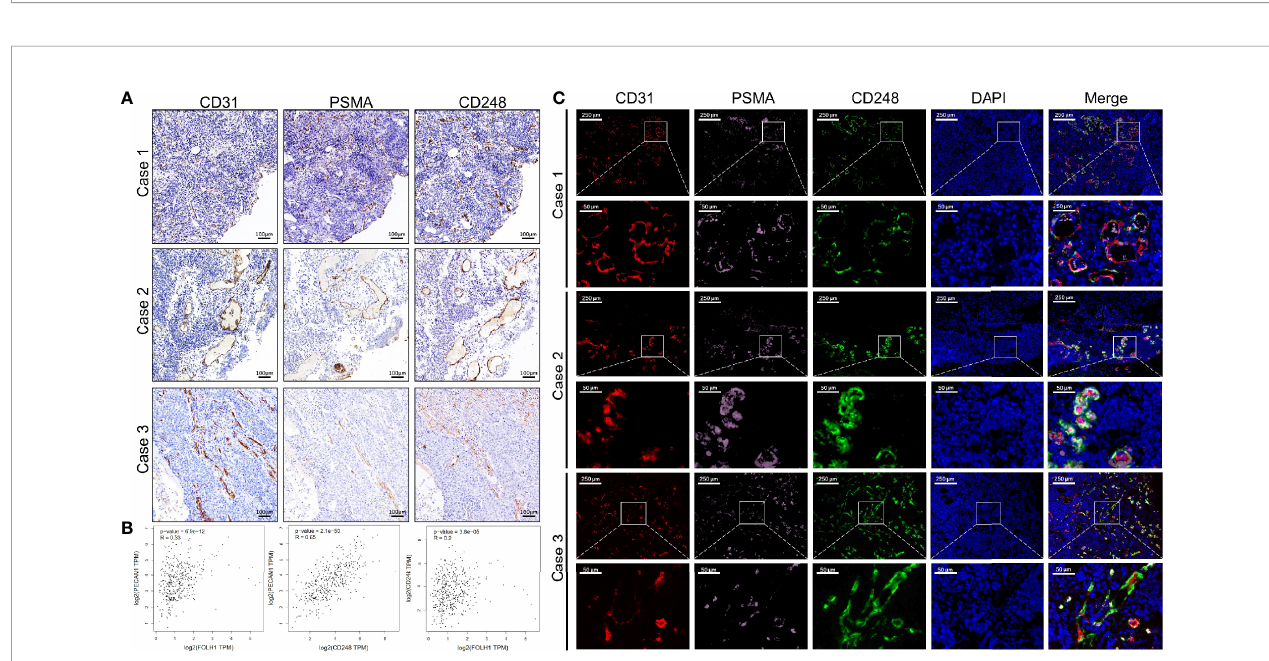
FIGURE 3 | The correlation between the expression levels of CD248 and PSMA in UCB vessels. (A) Representative IHC staining in serial paraf fi n sections of three cases with UCB, using CD31 as the positive control. Scale bar = 100 m m. (B) The correlation between the expression levels of CD31 , PSMA , and CD248 in UCB, respectively, using data from the GEPIA database. (C) Representative triple-immuno fl uorescence histochemistry for CD31 (red), PSMA (pink), and CD248 (green) in serial paraf fi n sections of three cases with UCB. Scale bar = 250 and 50 m m, respectively. Representative images are shown.